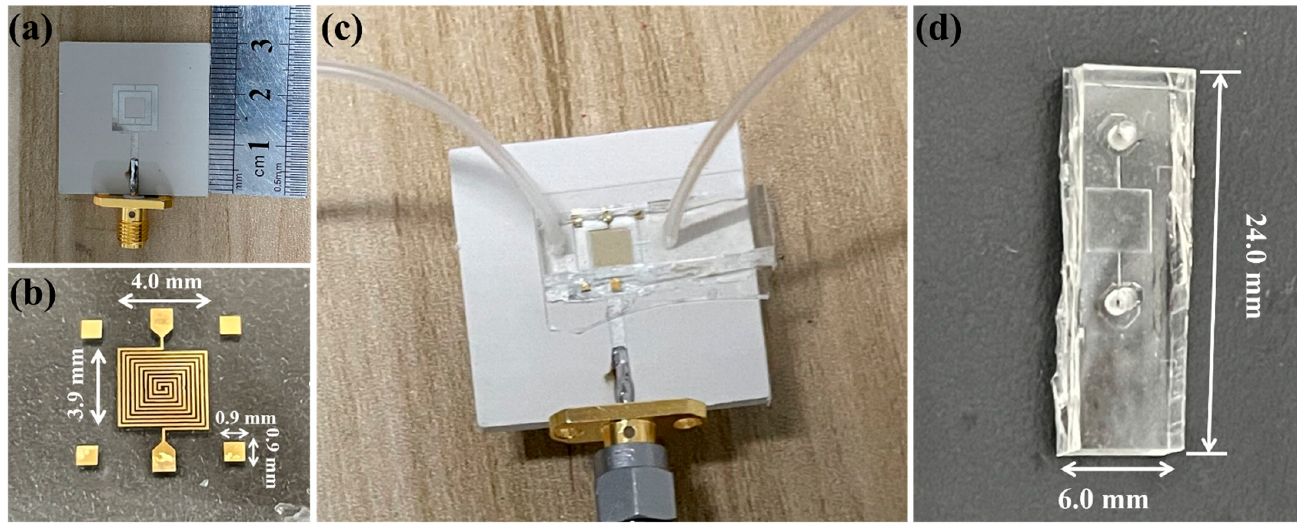
Figure 3. The fabricated RFID chip, including ( a ) Reader, ( b ) Tag, ( c ) RFID chip, and ( d ) microchannel.